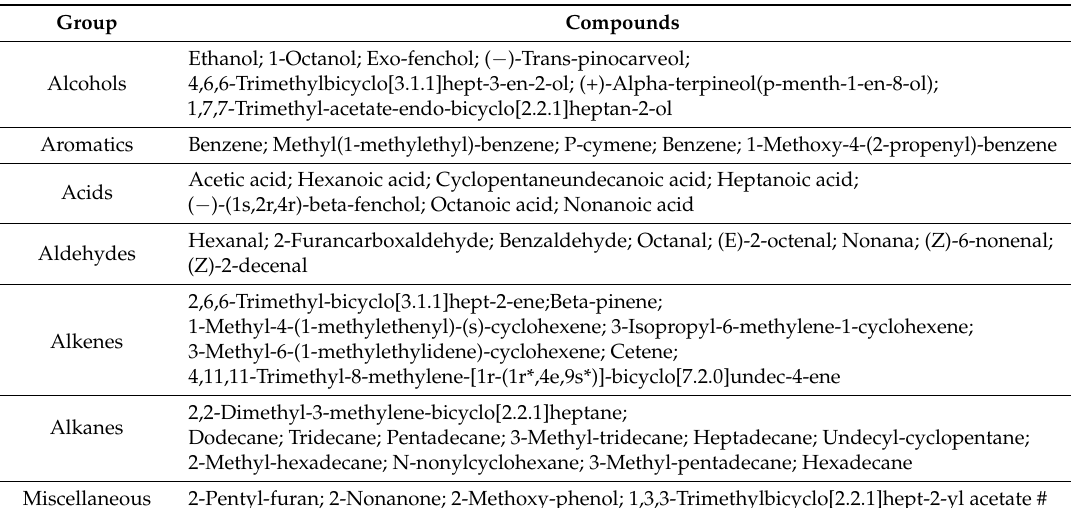
Table 3. Key volatile organic compounds of southern yellow pine before and after heat treatment.